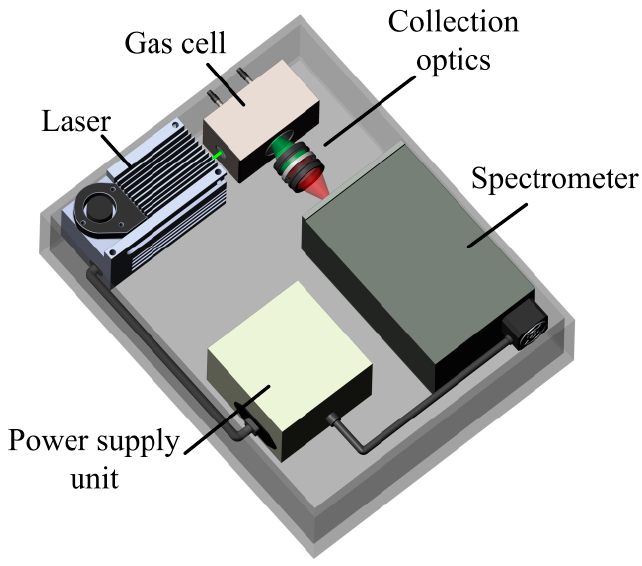
Figure 1. Schematic of Raman gas